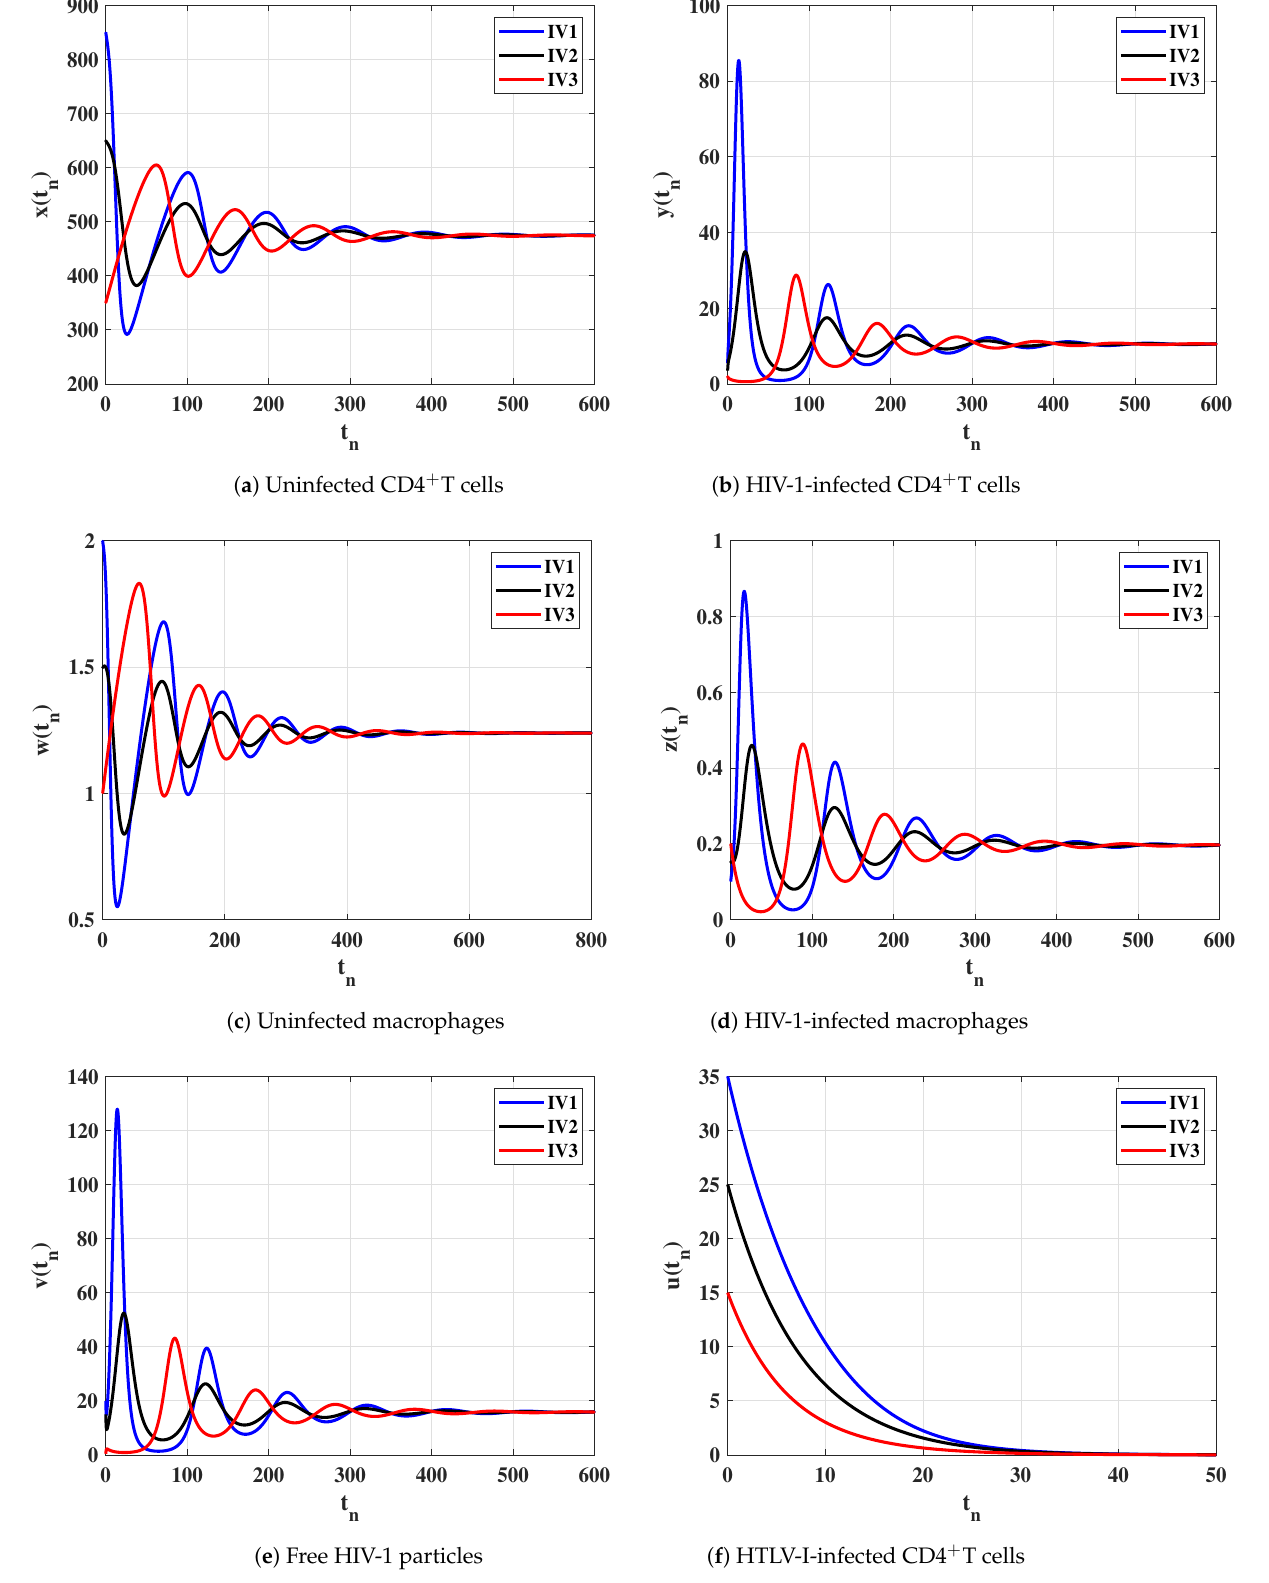
Figure 2. Solutions of model (10)–(15) with initial conditions IV1-IV3 in case of R 0 > 1 and R 1 ≤